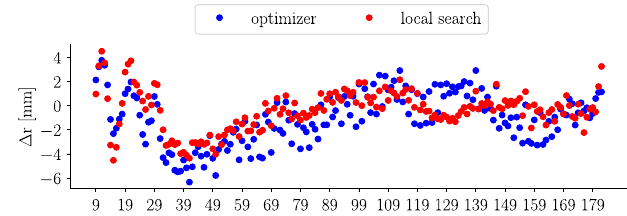
FIG. 22. Error of the turn radius at RRL between the meas- urement and simulation of the best individual obtained by multiobjective optimization and local search.